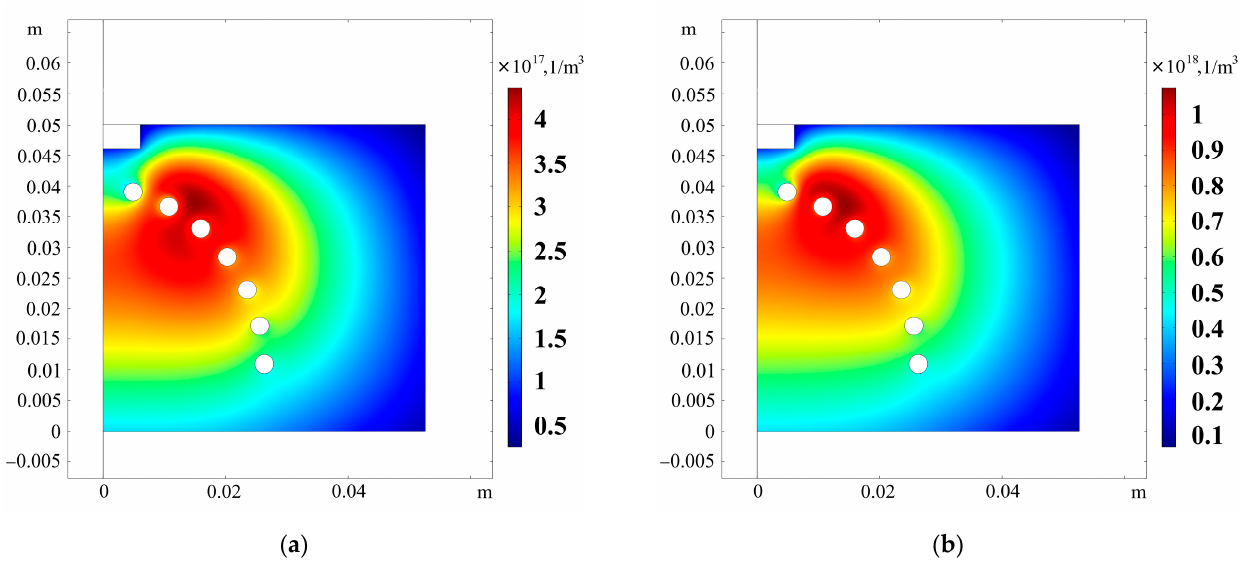
Figure 9. Two-dimensional distribution of charged particle density over the DC volume in the case of using an internal antenna with hemispherical arrangement of turns: ( a ) xenon flow rate of 0.5 mg/s, RF power of 71 W, extracted ion current of 140 mA; ( b ) xenon flow rate of 1 mg/s, RF power of 121 W, extracted ion current of 300 mA.